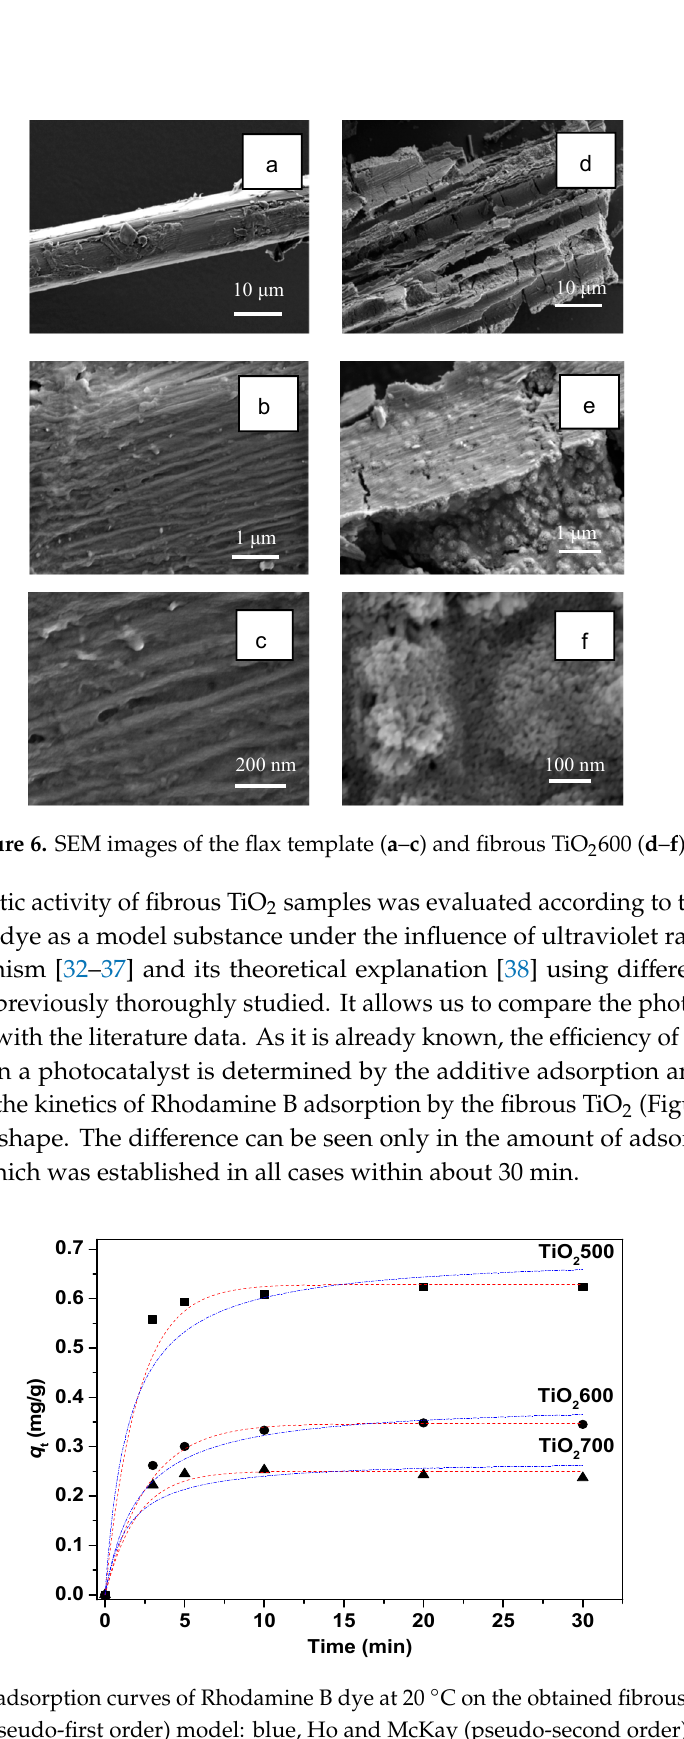
Figure 7. Kinetic adsorption curves of Rhodamine B dye at 20 °C on the obtained fibrous TiO 2 samples: red, Lagergren (pseudo-first order) model: blue, Ho and McKay (pseudo-second order). After a 30-min contact of the phases in the series of samples TiO 2 700, TiO 2 600, and TiO 2 500, the adsorption capacity with respect to Rhodamine B is successively increased. TiO 2 500 removed 37% of the dye from the solution, while TiO 2 600 and TiO 2 700 removed 20% and 14%, respectively. The data on adsorption capacity correlate well with the texture properties of photocatalysts (Table 2).